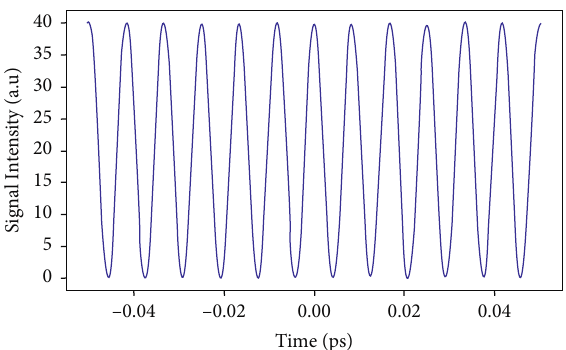
Figure 4: Signal intensity of a monochromatic